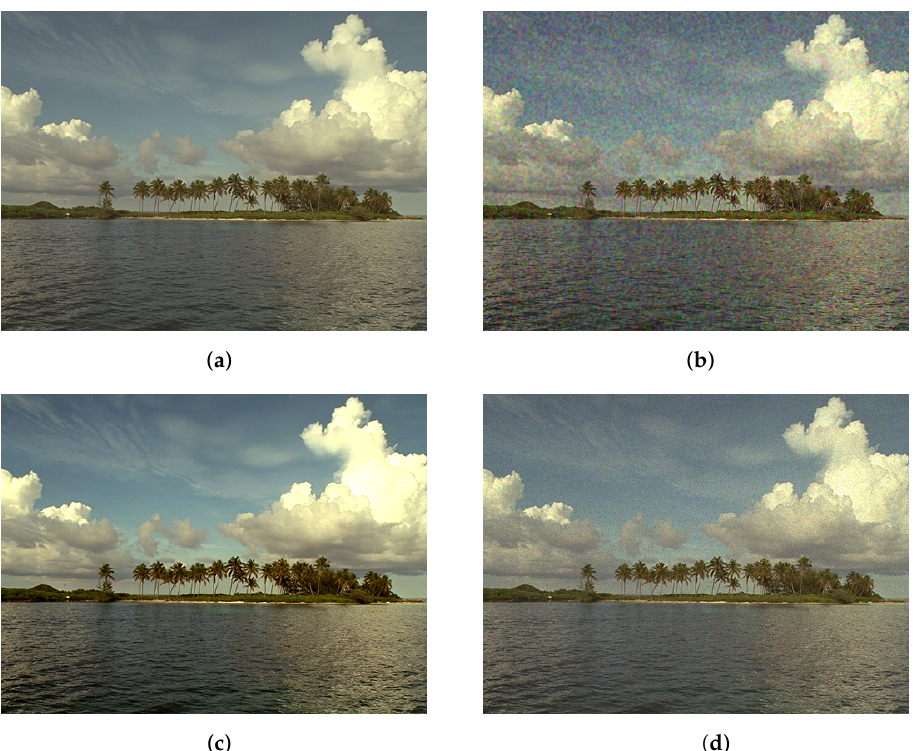
Figure 3. Sample images from TID2013 [51] with their MOS values: a) reference, pristine image, b) spatially correlated noise, MOS = 3.6923, c) contrast change, MOS = 6.6500, d) multiplicative Gaussian noise, MOS = 3.3750.